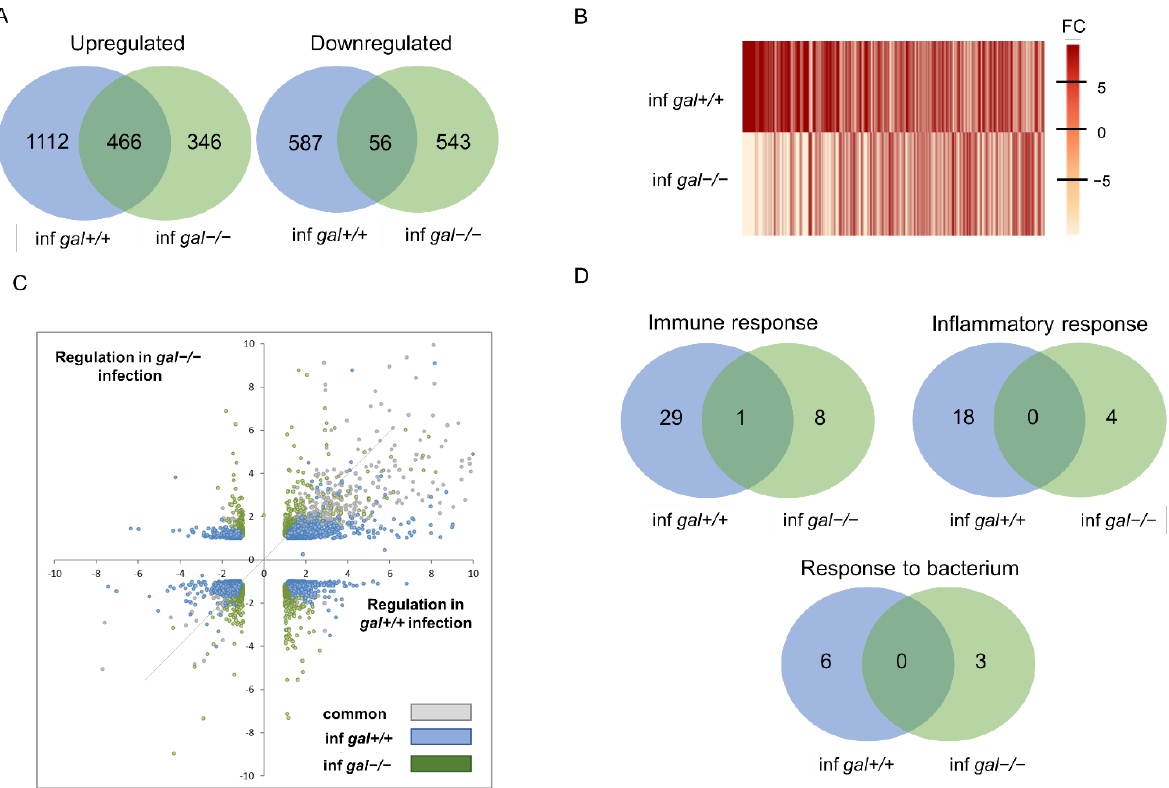
Figure 4. Transcriptome analysis by RNA-seq showing modulation of infection-induced gene regulation by galanin mutation. ( A ) Venn diagram showing overlaps between clusters of genes significantly upregulated or downregulated by infection of gal+/+ and gal − / − mutant larvae; ( B ) heat map displaying the normalized fold changes of transcripts that reached statistical significance as differentially expressed in infected gal+/+ and infected gal − / − zebrafish larvae; ( C ) scatter plot showing the effect of galanin deficiency on gene expression. For all genes showing significant regulation upon infection (blue and gray dots) or the combined infection in the mutant (gray dots). Gray dots represent the overlap between control infection and mutant infection. The gray line indicates the point at which galanin knockout treatment does not alter infection-induced gene regulation; ( D ) GO analysis for upregulated genes in biological processes. Paired analysis was per-formed using DESeq2 by comparing each group to each non-infected group. Significantly regulated genes were selected by using a p .adj < 0.05 and |FoldChange| > 1.5